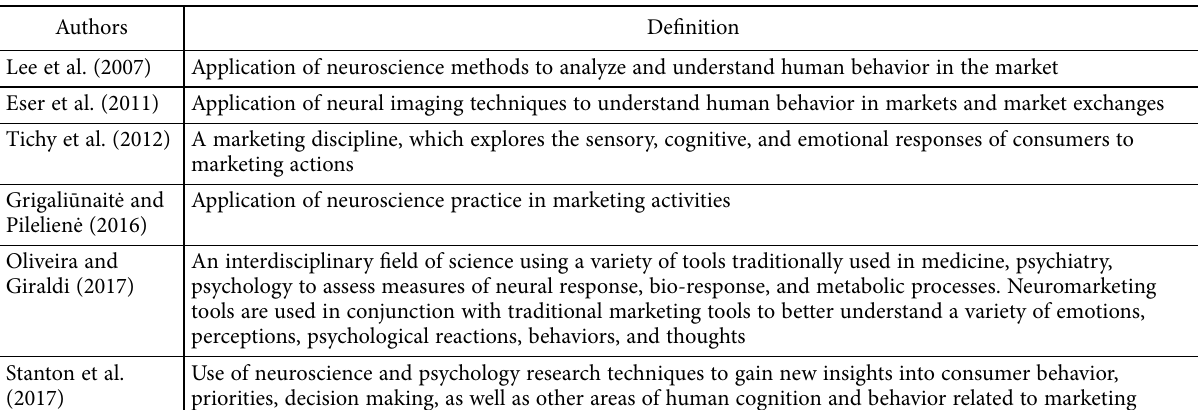
Table 1. Definitions of